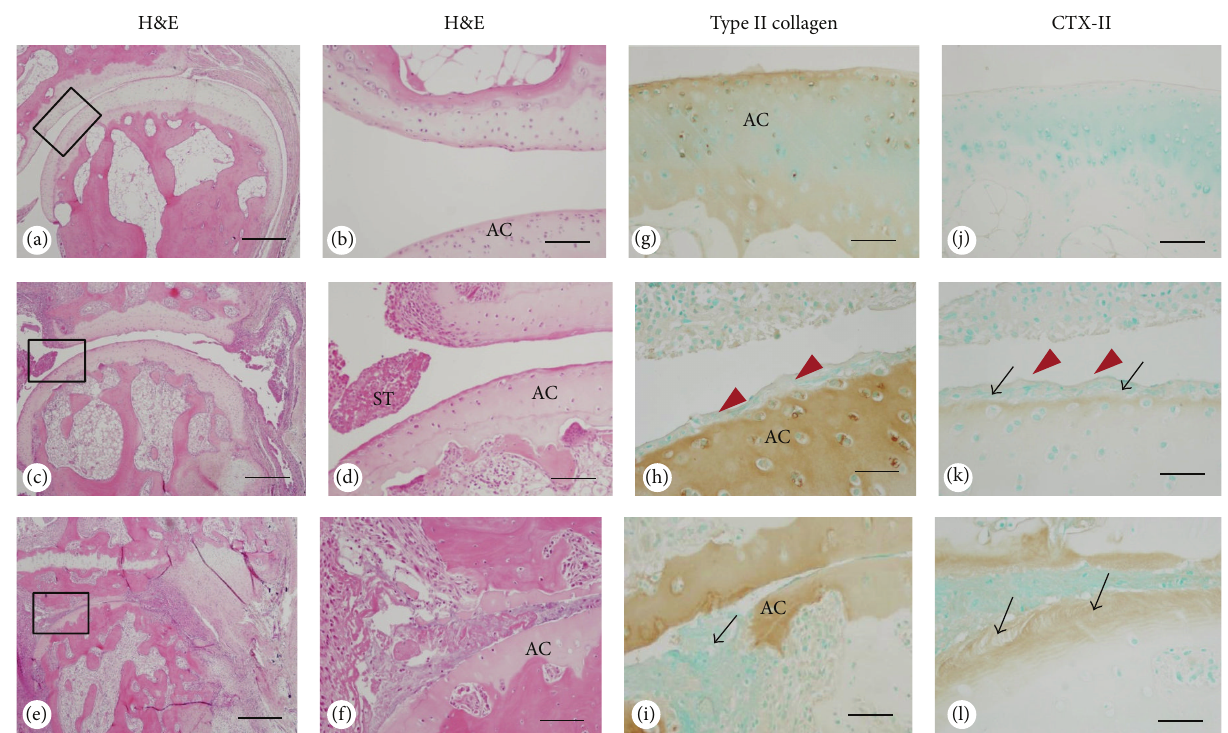
Figure 3: Histological analysis of sagittal sections of PIP joints of normal and arthritic monkeys. (a–f) Hematoxylin and eosin- (H&E-) stained sections of controls (a, b) and in arthritis with moderate (c, d) and severe (e, f) joint destruction. (g–l) Immunolocalization of type II collagen in controls (g) and in arthritis with moderate (h) and severe (i) joint destruction, and immunostaining of CTX-II in controls (j) and in arthritis with moderate (k) and severe (l) joint destruction. In moderate joint destruction, the superficial layer of articular cartilage showed CTX-II positivity (black arrows, k), while the deeper layer had no CTX-II reactivity. Note the unstained layer of type II collagen and CTX-II (red arrowheads, h and k). In severe joint destruction, the deeper layer of the articular cartilage became positive for CTX-II (arrows, l). Note the partial destruction of the articular cartilage (arrow, i). AC, articular cartilage; ST, synovial tissue. Bars: (a), (c), (e): 650 𝜇 m, (b), (d), (f): 120 𝜇 m, (g), (i), (j), (l): 100 𝜇 m, and (h), (k): 50 𝜇